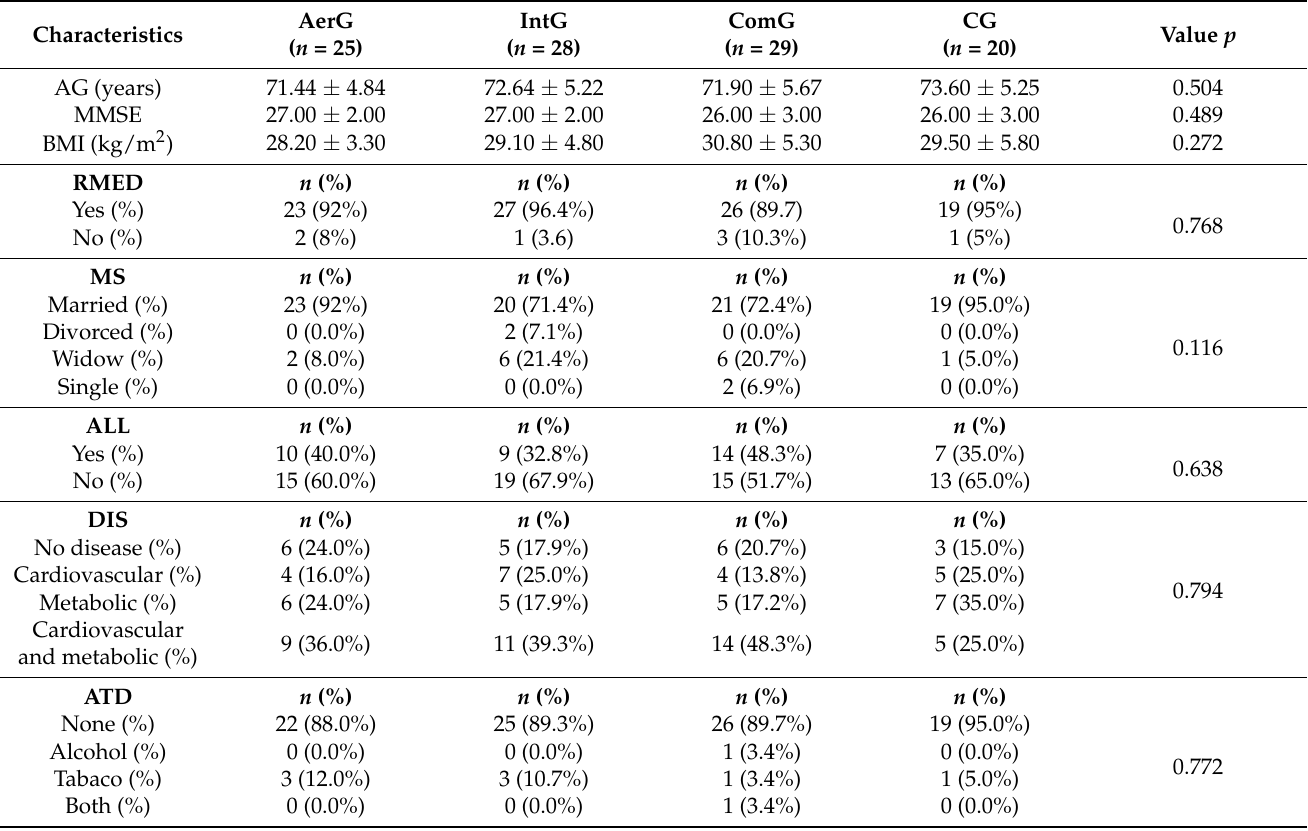
Table 1. Major sample characteristics at